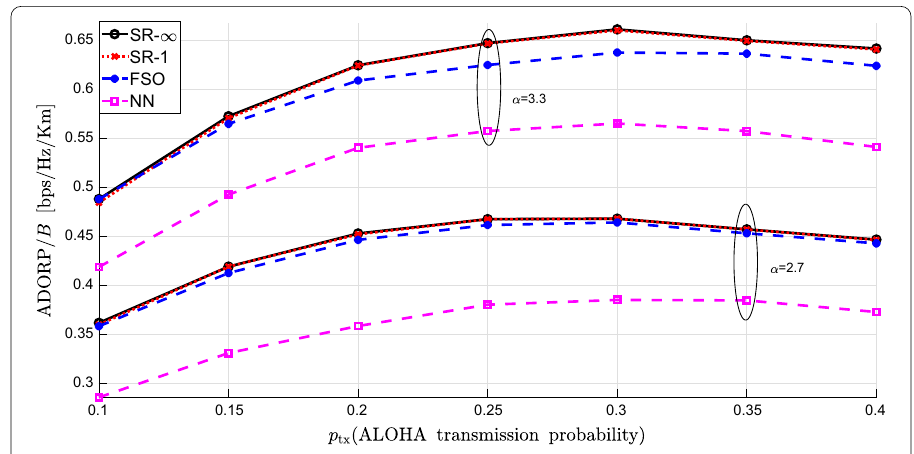
Fig. 2 PZF receiver: Normalized ADORP versus ALOHA transmission probability for the SR, FSO and NN schemes, where N = 2, π r 2 RZ = 10 and α = { 2.7,3.3